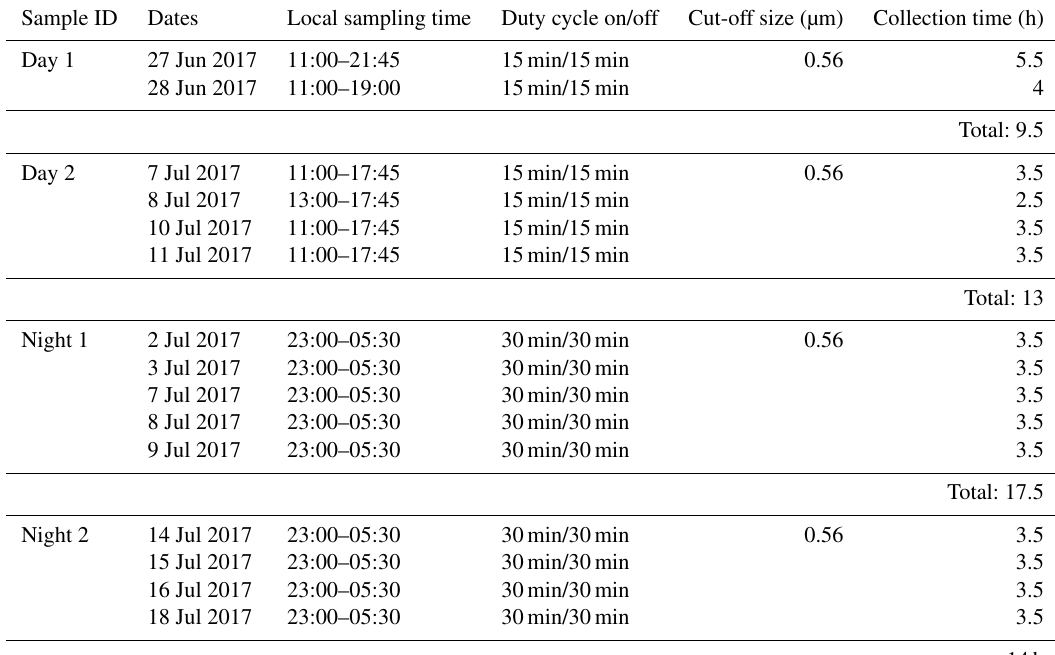
Table 1. Information about collection of particle samples including sample name, sampling dates and time periods, impactor cut-off size, impactor operation cycle, and total collection time. Sample ID Dates Local sampling time Duty cycle on/off Cut-off size (µm) Collection time